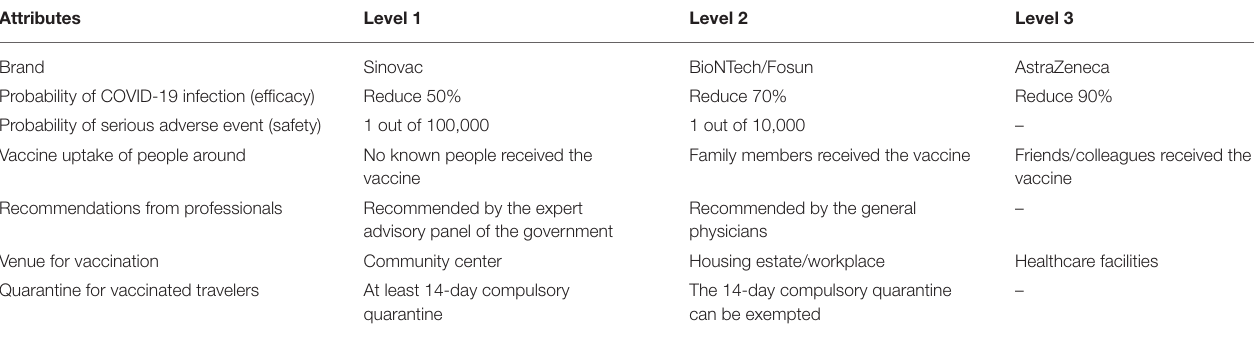
TABLE 1 | The attributes and levels of the DCE.